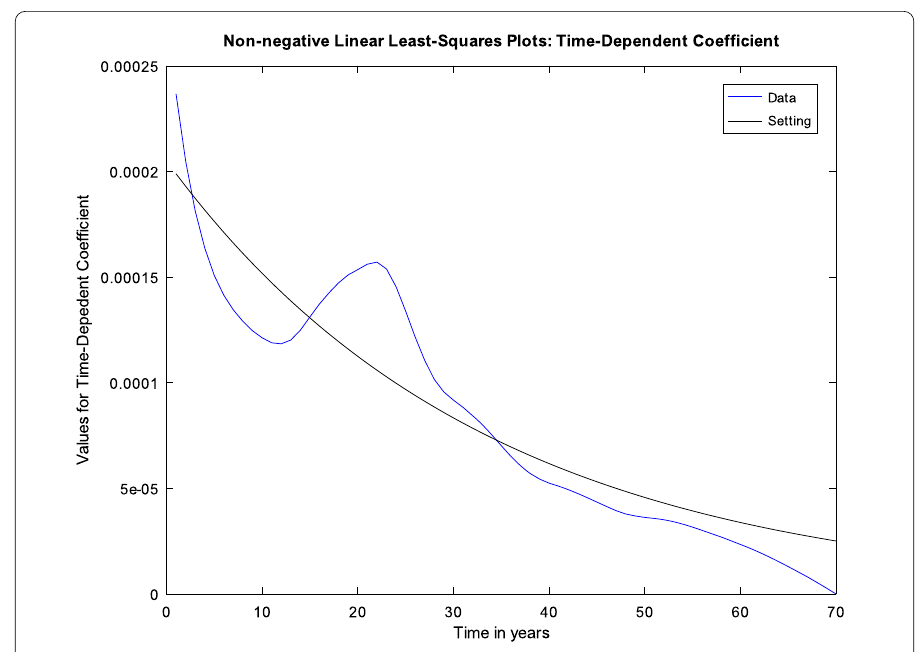
Figure 8 The results of our nonnegative linear least-squares optimization can be seen as the blue graph. Our user-chosen simplified time-dependent coefficient function is given by the black graph